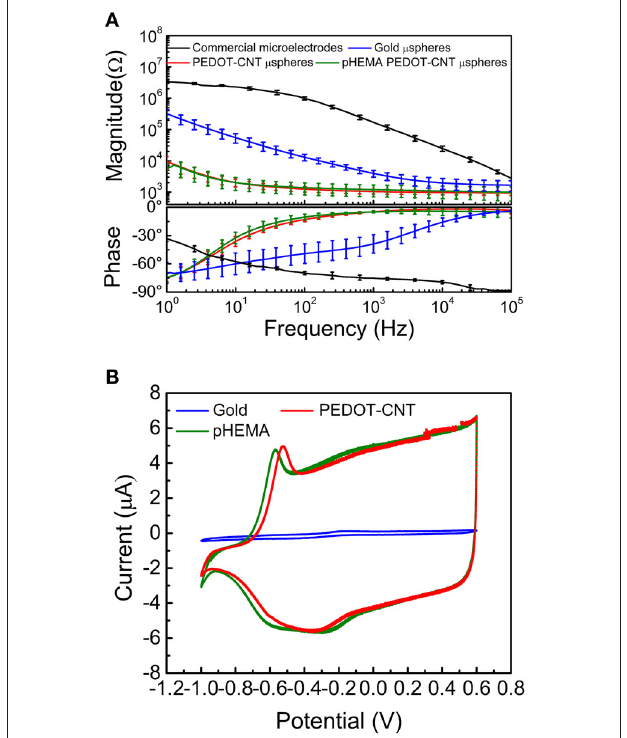
FIGURE 1 | (A) Impedance spectra of commercial microelectrodes (black), gold microspheres before (blue) and after (red) PEDOT-PSS-CNT electrodeposition and (green) PEDOT-PSS-CNT coated microspheres after pHEMA encapsulation. (B) Sample cyclic voltammograms of a gold microsphere (blue) and a PEDOT-PSS-CNT coated microsphere before (green) and after (red) pHEMA encapsulation.